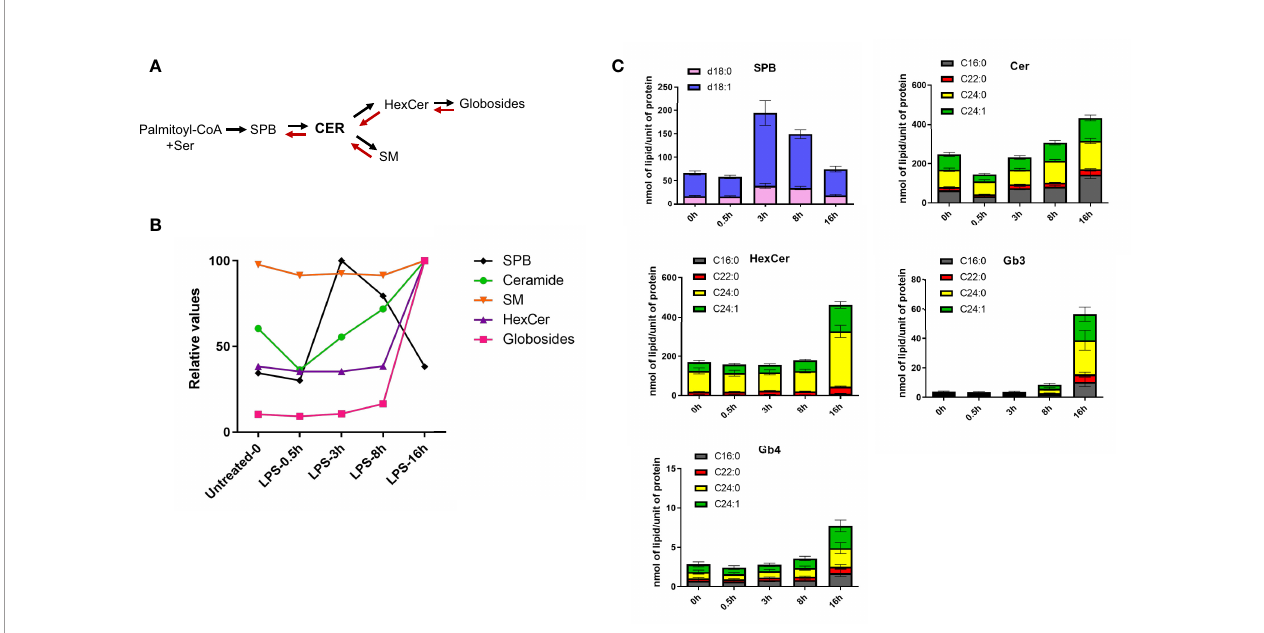
FIGURE 3 | LPS stimulation induces de novo sphingolipid synthesis in human macrophages. (A) The simpli fi ed schematics of sphingolipid biosynthesis. (B) LPS- induced kinetics for sphingoid bases (SPB), ceramides, sphingomyelins (SM), monohexosylceramides (HexCer) and globosides (Gb3 and Gb4). Relative values were calculated using the mean of each lipid class across the time-points. (C) Quanti fi cation of different sphingolipid species throughout the LPS-time course in human macrophages. SBP represent sphingosine (d18:1, blue) and sphinganine (d18:0, pink). All the ceramides, HexCer and globosides (Gb3 and Gb4) shown in the fi gure contain a d18:1 sphingoid base, while the fatty acyl chains (C16:0, C22:0, C24:0, C24:1) are indicated in different colors. Error bars are s.e.m.